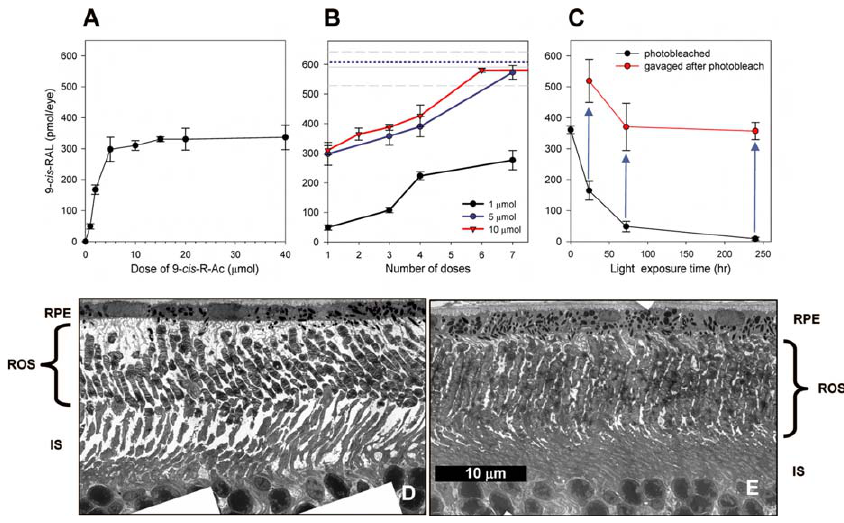
Figure 3. Levels of 9- cis -RAL Oximes in the Eyes of Lrat (cid:2) / (cid:2) Mice after a Single or Multiple Dose of 9- cis -R-Ac (A) The level of 9- cis -RAL in Lrat (cid:2) / (cid:2) mouse eyes after a varying dose of 9- cis -R-Ac. (B) The level of 9- cis -RAL in Lrat (cid:2) / (cid:2) mouse eyes after a varying size and number of doses of 9- cis -R-Ac. The solid gray line represents a maximal level of isorhodopsin as measured by the level of 9- cis -retinal oximes in Lrat (cid:2) / (cid:2) mouse eyes after ten gavages; dashed gray line indicates the SD. The maximal level of isorhodopsin is comparable to the level of rhodopsin in WT mice (blue dotted line, shown as pmol of 11- cis -retinal/eye). (C) The level of 9- cis -RAL in Lrat (cid:2) / (cid:2) mouse eyes after 9- cis -R-Ac treatment and light exposure or after exposure to light and re-gavage ( n (cid:4) 3, data shown with SD). (D and E) Changes in the RPE-ROS interface in control Lrat (cid:2) / (cid:2) mice and Lrat (cid:2) / (cid:2) mice treated with 9- cis- R-Ac. Treated Lrat (cid:2) / (cid:2) mice were gavaged with 9- cis -R-Ac (10 l mol per gavage) six times, 3 d apart, and analyzed (D). Control retina from age-matched (8 wk old) untreated Lrat (cid:2) / (cid:2) mice (E). Considerably improved RPE-ROS processes were observed in all treated mice. RPE, retinal pigment epithelium; ROS, rod outer segments; IS, inner segments. Scale bar, 10 l m. DOI: